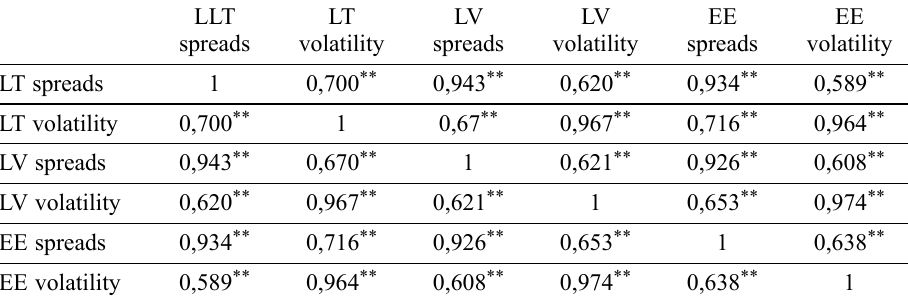
Table 2. Correlations between CDS spreads and volatility of CDS of the Baltic countries LLT LT LV LV EE EE spreads volatility spreads volatility spreads volatility LT spreads 1 0,700 ** 0,943 ** 0,620 ** 0,934 ** 0,589 ** LT volatility 0,700 ** 1 0,67 ** 0,967 ** 0,716 ** 0,964 ** LV spreads 0,943 ** 0,670 ** 1 0,621 ** 0,926 ** 0,608 ** LV volatility 0,620 ** 0,967 ** 0,621 ** 1 0,653 ** 0,974 ** EE spreads 0,934 ** 0,716 ** 0,926 ** 0,653 ** 1 0,638 ** EE volatility 0,589 ** 0,964 ** 0,608 ** 0,974 ** 0,638 ** 923